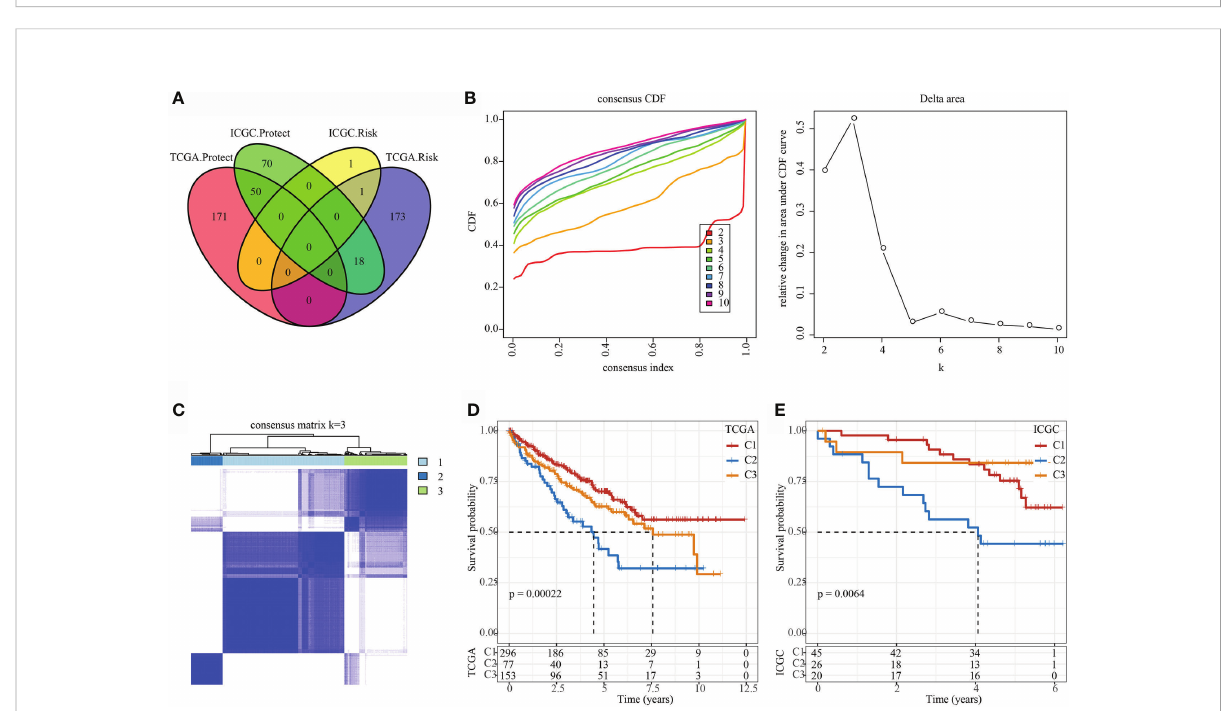
FIGURE 5 Identi fi cation of epi-PCGs-related molecular subtypes. (A) Venn diagram of prognostic signi fi cant genes in TCGA and ICGC data set obtained by univariate Cox regression analysis; (B) CDF curve and CDF Delta area curve of TCGA cohort samples (n = 526). Delta area curve of consensus clustering, which indicates the relative change in area under the cumulative distribution function (CDF) curve for each category number k compared with k – 1. The horizontal axis represents the category number k and the vertical axis represents the relative change in area under CDF curve; (C) Cluster heat map of TCGA data set samples (n = 526) when k = 3; (D) KM curve of the prognosis of the three molecular subtypes in the TCGA data set (n-C1 = 296, n-C2 = 77, and n-C3 = 153); (E) KM curve of the prognosis of the three molecular subtypes in the ICGC data set (n-C1 = 45, n-C2 = 26, and n-C3 =